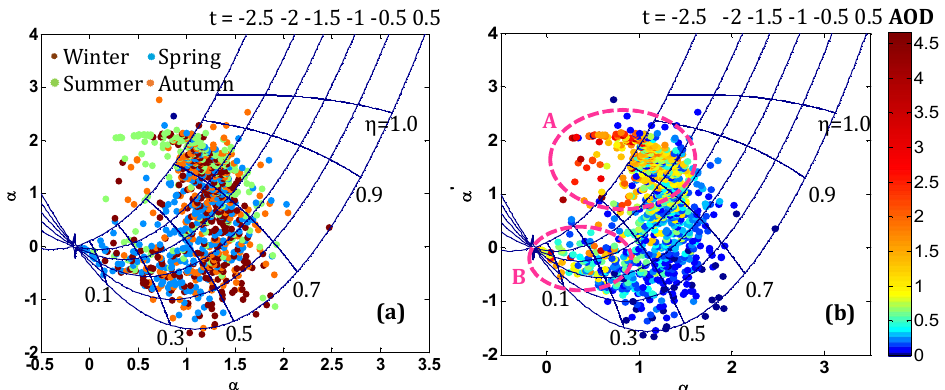
Figure 2. Aerosol properties distribution for different seasons and aerosol optical depth (AOD) levels (reference wavelength of λ = 500 nm) of five AERONET stations in the year 2015 (n = 975). Different colors in ( a ) refer to different seasons; and in figure 2b refer to different AOD levels. The circle A and B in ( b ) refer to different type of samples. α, α′, η, refers to the Angstrom coefficient, the instantaneous slope of α versus lnλ, fine mode fraction, t is an intermediate variable in η retrieving based on the spectral deconvolution algorithm (SDA) [33].